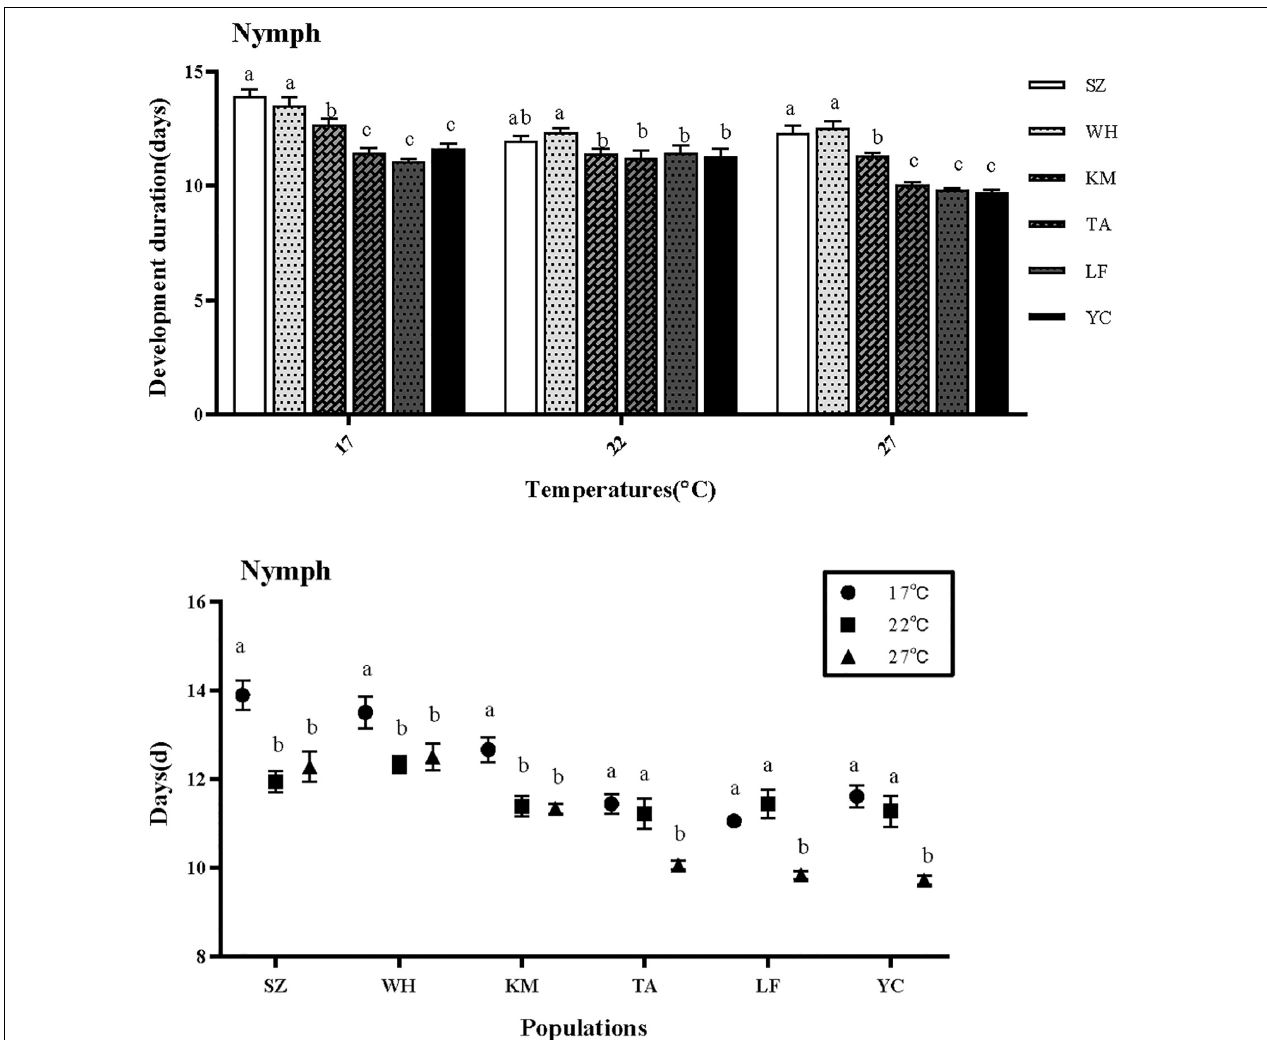
FIGURE 2 | Effect of different temperatures on nymphal development duration of S. miscanthi. The legend is ordered from highest to lowest MAT. SZ, Suzhou; WH, Wuhan; KM, Kunming; TA, Tai’an; LF, Langfang; YC,